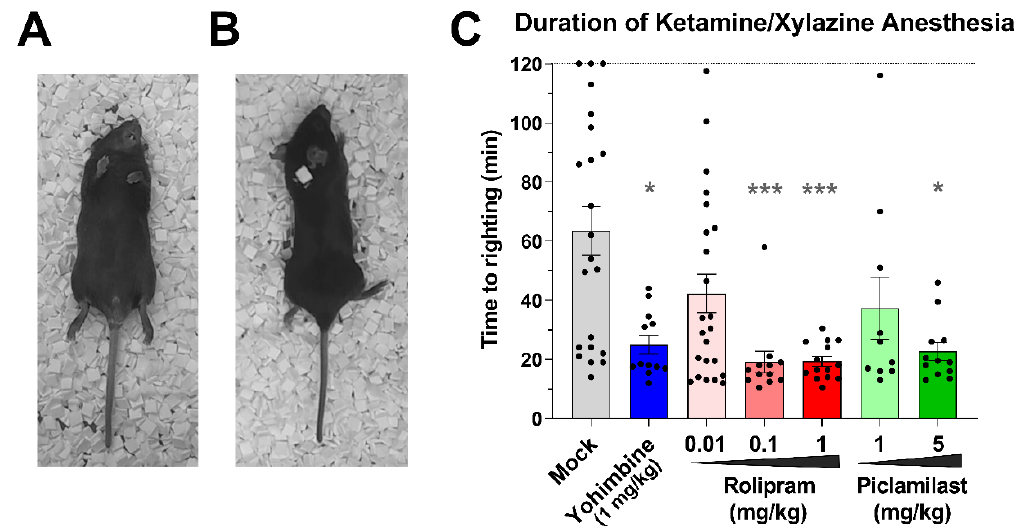
Figure 1. PAN-selective PDE4 inhibition shortens the duration of Ketamine/Xylazine-induced anesthesia via α 2 -adrenoceptor antagonism. ( A , B ) Representative images illustrating the measurement of “Time to righting”. Upon induction of anesthesia and the resulting loss of righting (~3 min after Ketamine/Xylazine injection), the unconscious mice are placed on their backs ( A ). As the anesthetic effect of Ketamine/Xylazine wears off and the animals awaken, the righting reflex, an automatic reaction to move the body to its normal/prone position, kicks in and the mice turn onto their abdomen ( B ). The time from loss of righting to the time of first righting is recorded. ( C ) Mice were anesthetized with a combination of Ketamine (80 mg/kg) and Xylazine (10 mg/kg) administered by intraperitoneal injection. Ten minutes later, the animals were injected intraperitoneally with the α 2 ‐ adrenoceptor antagonist Yohimbine (1 mg/kg), the PAN ‐ PDE4 inhibitors Rolipram (0.01, 0.1, or 1 mg/kg) or Piclamilast/RP73401 (1 or 5 mg/kg) or solvent control (Mock). The mice were then placed in dorsal recumbency and the time to first righting was measured. Data represent the mean ± SEM. Statistical analysis was determined using the Kruskal–Wallis test followed by Dunn’s post hoc test and is indicated as * ( p < 0.05) or *** ( p < 0.001).